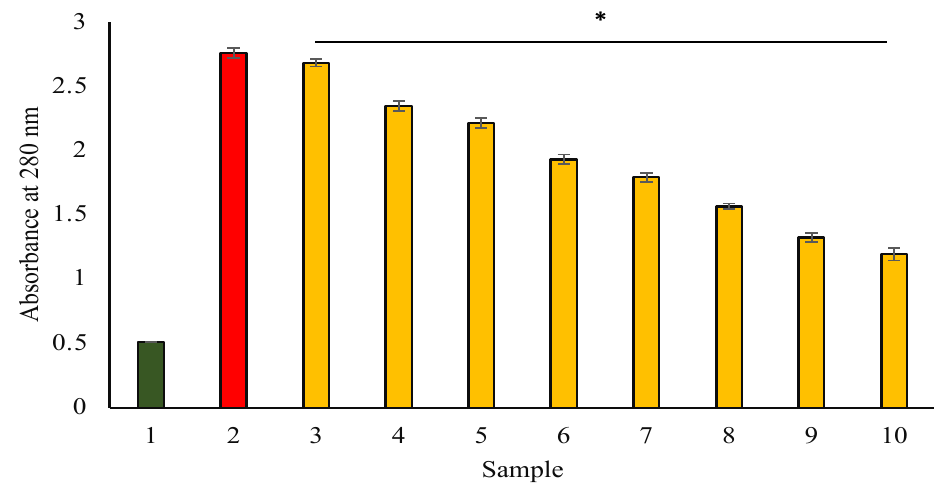
Figure 9. Absorbance at 280 nm vs. concentration (µg/mL)—Sample 1 (green pattern) shows native BSA that was incubated alone for 15 days, sample 2 (red pattern) represents BSA kept with glucose in the absence of myrrh extract for 15 days, samples 3 to 10 at X-axis indicate BSA kept for 15 days with glucose and myrrh extract’s various concentrations (50, 75, 100, 200, 300, 400, 500, and 600 µg/mL) (yellow pattern). The data are shown as means ± standard error of the means (n = 3, p < 0.05). The statistical differences are represented with an asterisk (*) for myrrh denoting significance at p < 0.05 in comparison with the reference sample.